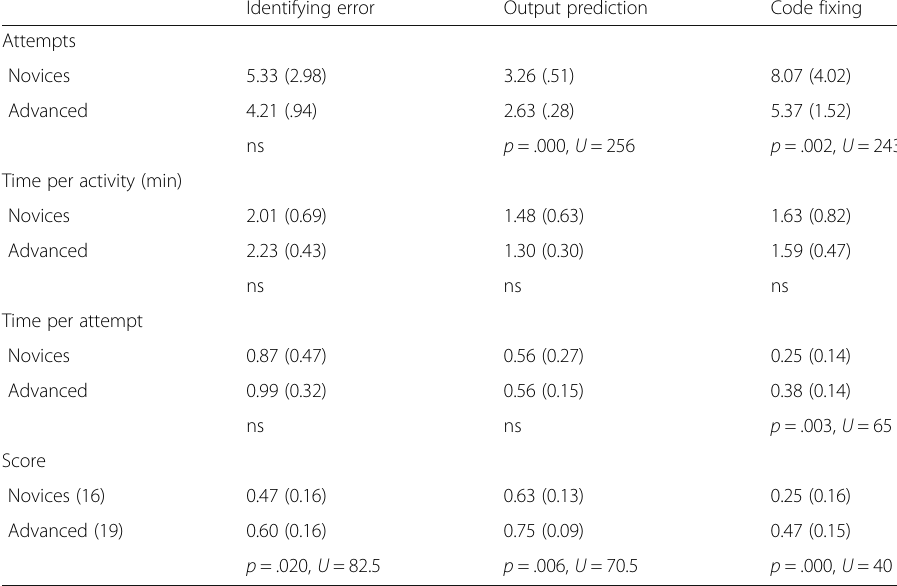
Table 5 Novices vs. advanced students performance measures ( ns denotes not significant) Identifying